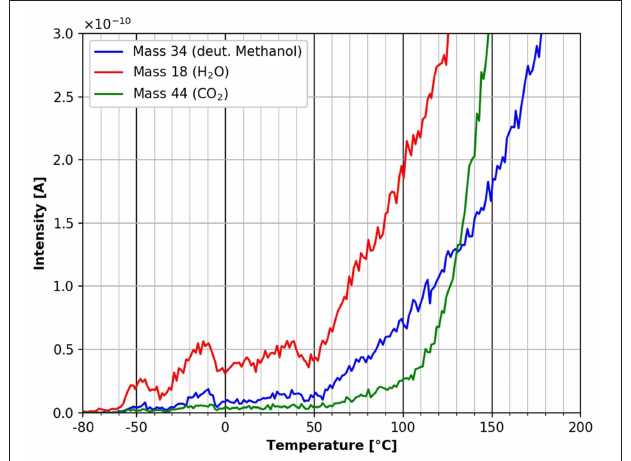
FIGURE 9 | Desorption of n-decane (mass 57, blue), carbon dioxide (mass 44, green) and water (mass 18, red) in the temperature range between 200 and 550 ◦ C.